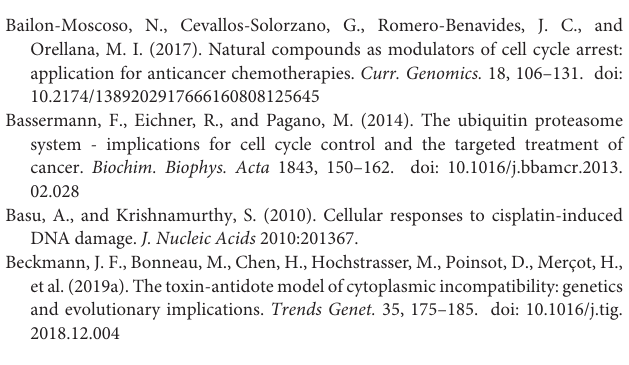
Supplementary Figure 1 | Sub-sampling analyses, in tests for chemical suppression of w Ri-induced CI. The likelihood of satisfying set p -values is shown for “hit” compounds identified by chemical screening. Compound treatments are color coded as indicated at the bottom of the figure. For NaBu, the data reached 100% satisfaction of the cutoff p < 0.05 at 12 wells, and p < 0.01 at 15 wells. For Teniposide, the data reached 100% satisfaction of the cutoff p < 0.05 at 11 wells, and p < 0.01 at 14 wells. All other conditions showed a 95%+ likelihood of satisfying p < 0.05, and an 80%+ likelihood of satisfying p < 0.01, at n = 16 wells. Supplementary Figure 2 | Sub-sampling analyses, in tests for chemical suppression of w Mel-induced CI. The likelihood of satisfying set p -values is shown for “hit” compounds identified by chemical screening. Compound treatments are color coded as indicated at the bottom of the figure. The data showed a 72–82% likelihood of satisfying p < 0.05, and a 47–72% likelihood of satisfying p < 0.01, at n = 16